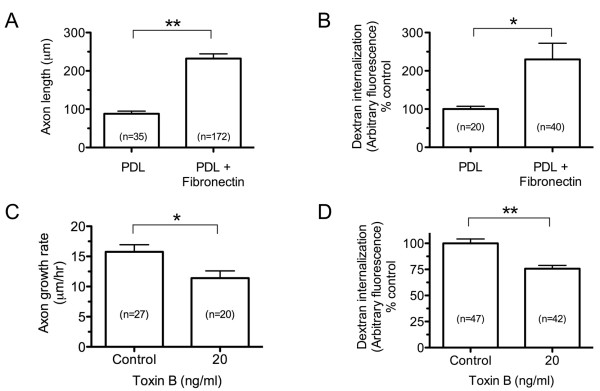
Endocytic activity correlates with axon outgrowth and requires Rho GTPases. (A) Summary of axon length measurements from spinal neuron cultures grown on poly-d-lysine (PDL) or PDL with fibronectin. (B) Summary of fluid-phase endocytosis levels measured in spinal neuron growth cones cultured on the indicated substrates. Fluorescent dextran was applied for 10 minutes and the amount of internalization was measured by fluorescence microscopy. The mean fluorescence intensity of each growth cone was normalized to the mean control (PDL). (C) Summary of growth rate measurements during the one-hour growth assays with or without pre-treatment with Toxin B (20 ng/ml). (D) Summary of fluid-phase endocytosis levels measured as in (B) under the indicated conditions. All data (A-D) are the mean ± standard error of the mean and the number of axons measured per condition is indicated in each bar. *P < 0.05, **P < 0.001, t-test or Mann-Whitney U-test (see Methods).